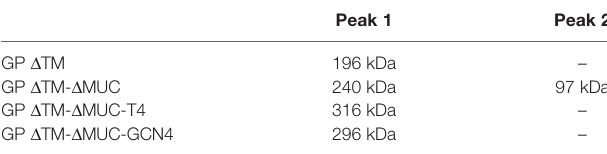
TABLE 1 | SEC-MALS absolute determination of the proteins ’ molecular